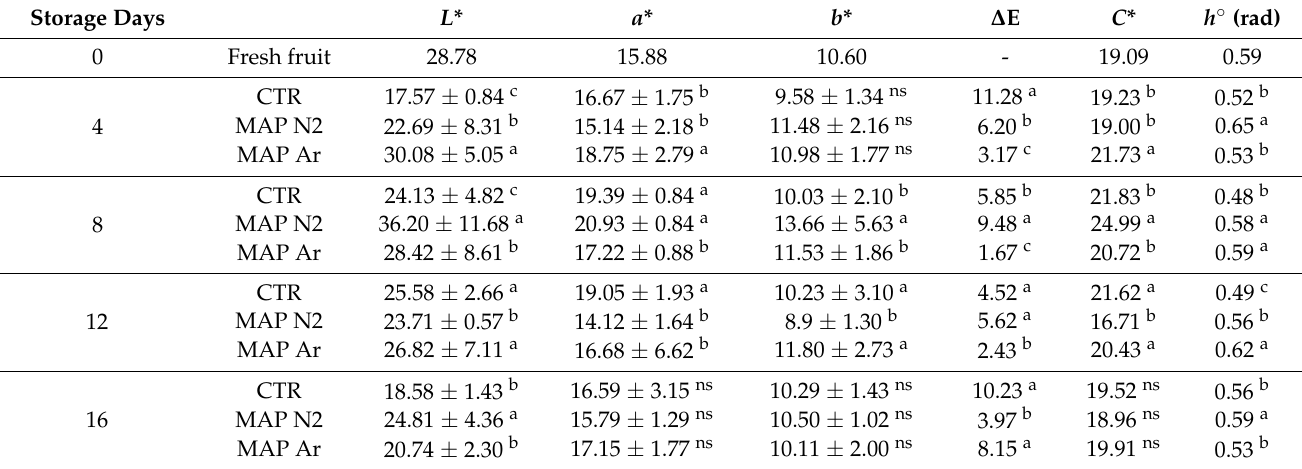
Table 4. Evolution of the CIE L * a * b * coordinates measured on the arils and their values of color difference, chroma, and hue angle (lightness ( L *); redness ( a *); yellowness ( b *); color difference ( ∆ E); chroma ( C *); hue angle ( h ◦ , rad)) treated with modified atmosphere packaging (CTR: 20.9% O 2 + 0.04% CO 2 (passive-MAP); MAPN 2 : 10% O 2 + 5% CO 2 + 85% N 2 ; MAPAr: 10% O 2 + 5% CO 2 + 85% Ar). Different letters indicate statistical differences ( p ≤ 0.05) between treatments for the same storage times. Letter “a” denotes the highest value, “ns” denotes no significant difference. Values were recorded at